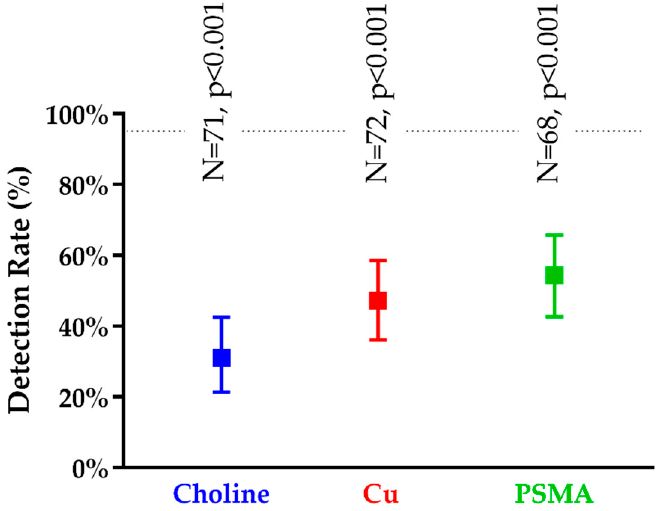
Figure 4. Detection rates (95%CI) of true positive lesions for PET/CTs. The number indicates the detectable lesions for each imaging modality. The p -value refers to the paired comparison of a given PET/CT with mpMR. The horizontal dashed black line corresponds to the lower 95%CI of DR for mpMR.